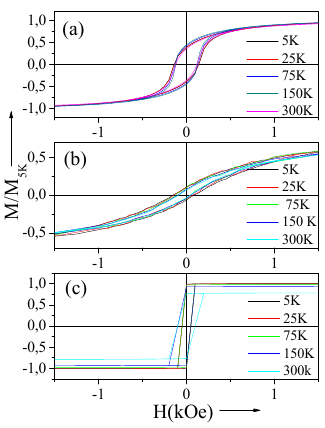
Figure 34. Hysteresis loops of Fe 64.7 Pt 33.3 B 2 ( a ), Fe 50 Pt 50 ( b ) and Fe 50 Pt 40 Si 10 ( c ) microwires. Reproduced from reference [48], Figure 1.